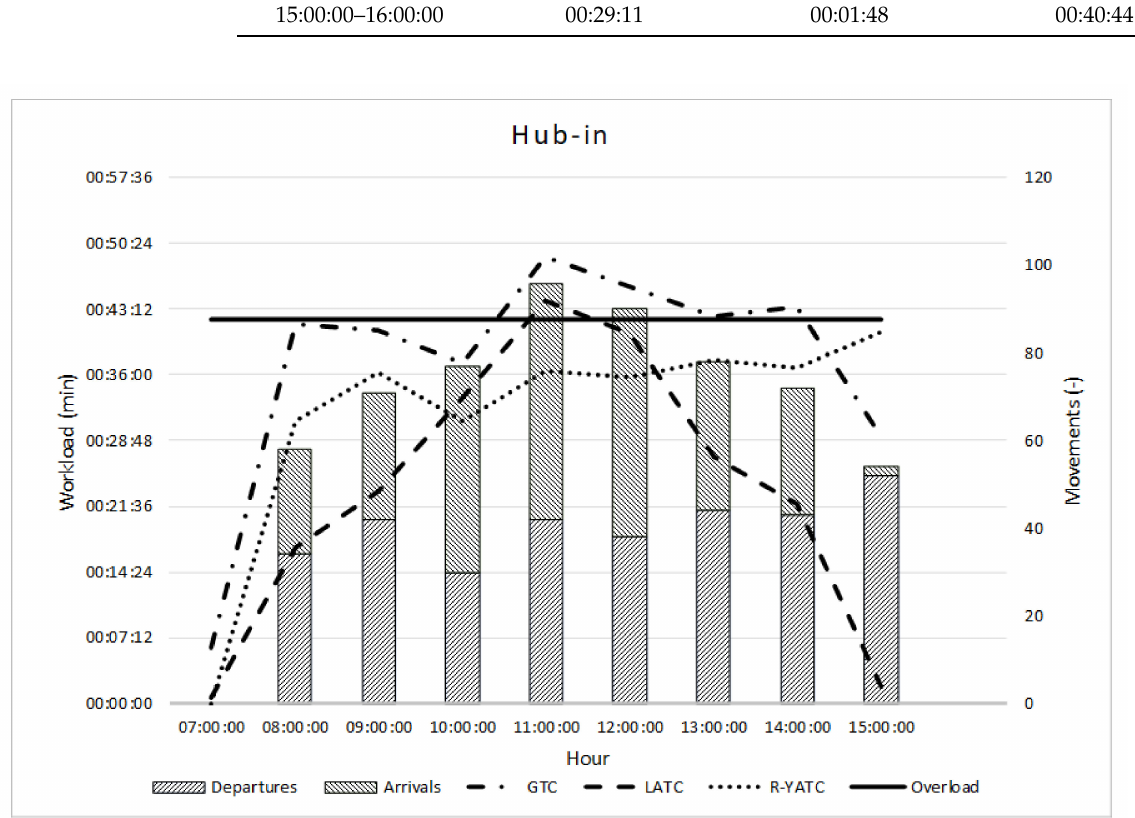
Figure 3. Hub-in workload and